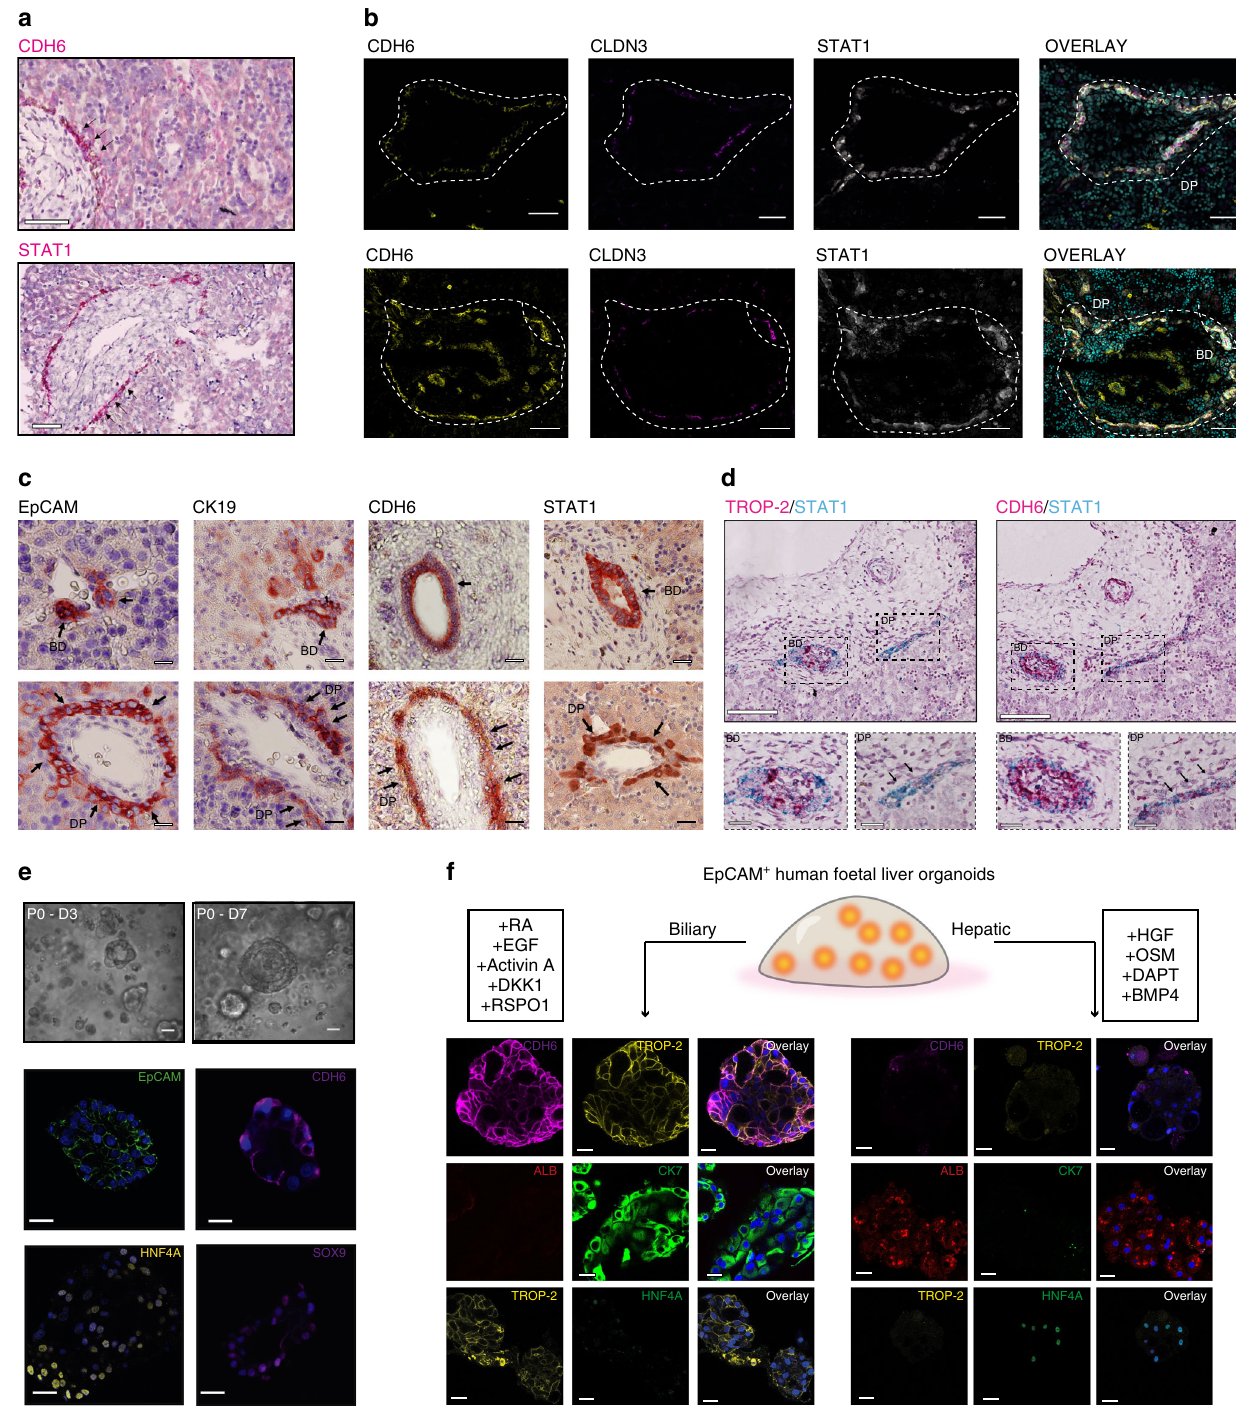
Fig. 4 TROP2 − foetal HHyPs are restricted to the ductal plate of foetal liver. a RNA- ISH for CDH6 and STAT1 on human second trimester (15 – 21 pcw) foetal liver ductal plate (DP) and bile duct (BD) regions. Scale bars represent 50 μ m. b Immuno fl uorescence (IF) staining of CDH6 (yellow), CLDN3 (magenta) and STAT1 (grey) co-expression in human foetal liver slides. Slides counterstained in DAPI (cyan). DP and BD structures outlined in white. Scale bars represent 25 μ m. c Immunohistochemistry (IHC) of EpCAM, CK19, CDH6 and STAT1 in BD and DP regions of human foetal liver. Scale bars represent 50 μ m. d Duplex RNA-ISH for CDH6 (red)/ STAT1 (blue) and TROP-2 (red)/ STAT1 (blue) in foetal liver BD and DP structures. Scale bars represent 50 μ m. Scale bars of zoomed in region represent 25 μ m. e Phase contrast imaging and IF of foetal intra-hepatic organoids (f-IHOs) derived from EpCAM enriched foetal liver cells in liver expansion (LE) media. All structures are counterstained with DAPI (blue). All staining performed between passages 3 and 5. f Schematic and IF staining of f-IHOs cultured for 7 days in hepatic differentiation (HD media) and biliary differentiation (BD media). All staining performed between passages 3 and 5. Images representative of n = 3 foetal liver differentiation